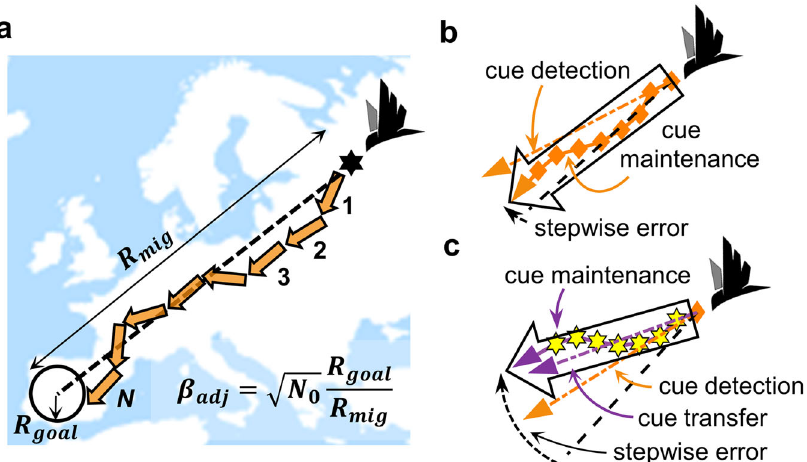
Fig. 1 Compass-based movement, precision between and within fl ight-steps. a Schematic of N migratory fl ight-steps (orange arrows), based on a single preferred heading (dashed black line), spanning a distance R mig to a migratory destination ( “ goal area ” , with radius R goal ). For a given and suf fi ciently high precision among fl ight-steps, and ignoring spherical-geometry effects, the probability of successful arrival increases with goal area, the number of required error-free fl ight-steps, N 0 , but decreases with migration distance (inset and Eq. (3)). b Within- fl ight compass precision based on a single (e.g., geomagnetic) cue. The expected initial error in cue detection (angle between dashed orange and black lines) will on average be offset by repeated, e.g., hourly cue maintenance within fl ight-steps (solid orange line and diamond shapes). c Contrastingly, with transfer to a secondary compass (dashed-purple line, e.g., star compass), the expected fl ight-step error will exceed cue-detection errors, regardless of cue maintenance (solid purple line and yellow hexagons). Bird icon from http://www.dreamstime.com (ID